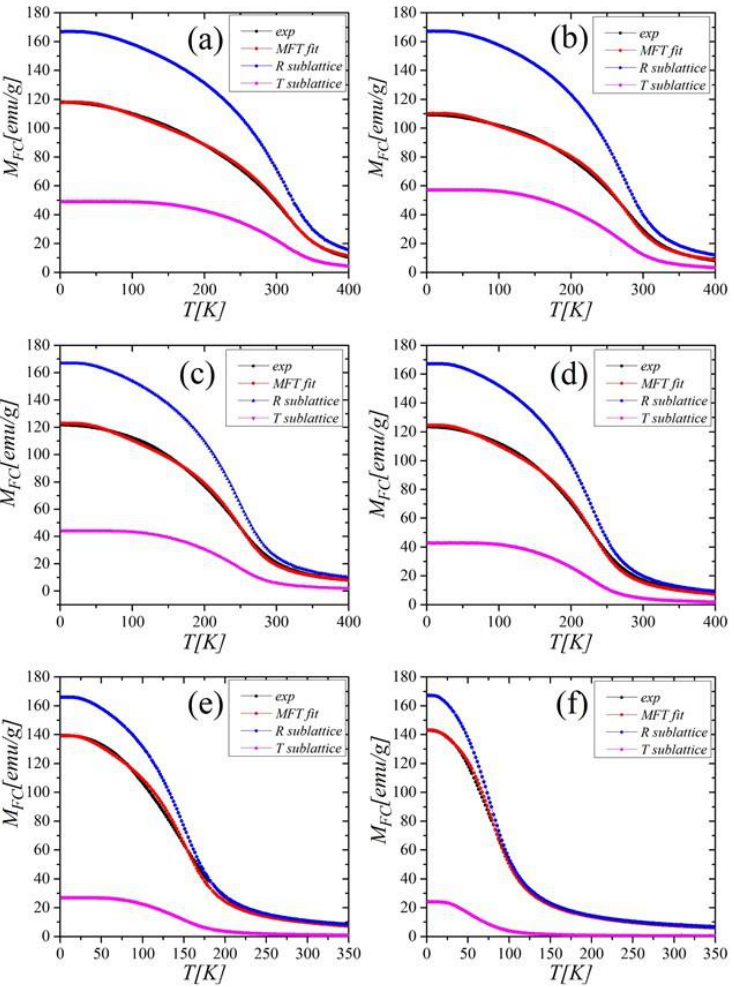
Figure 7. The M FC ( T ) dependence at μ 0 H = 5 T ( exp ) and the results of MFT analysis for Gd 0 . 4 Tb 0 . 6 (Co 1- x Ni x ) 2 compounds with concentrations x = 0.00; 0.05; 0.10; 0.15; 0.50; and 0.80 (figures ( a – f ), respec- tively). Table 2. The exchange integrals J RR , J RT , J TT , and magnetic moments of the 3 d sublattice calculated in the framework of MFT theory (2 μ 3 d-MFT )